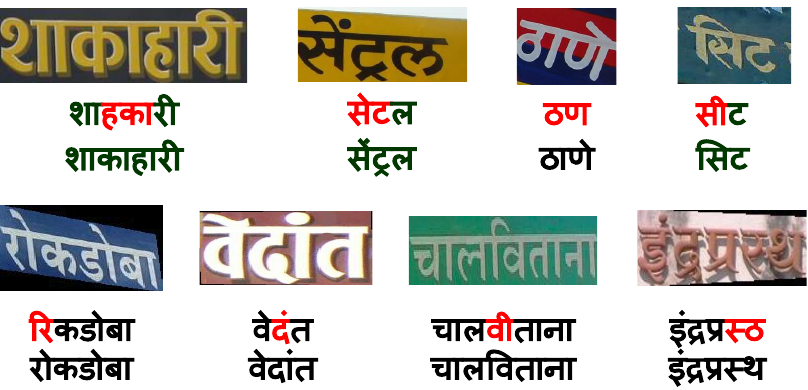
Figure 9. Examples of real images from IIIT-ILST ( top ) and MLT-19 ( bottom ) Hindi datasets. Be- low the images—(i) Baseline 2 predictions, (ii) correct predictions by Baseline 2 model with increased fonts and augmentation. Text in red represents errors.